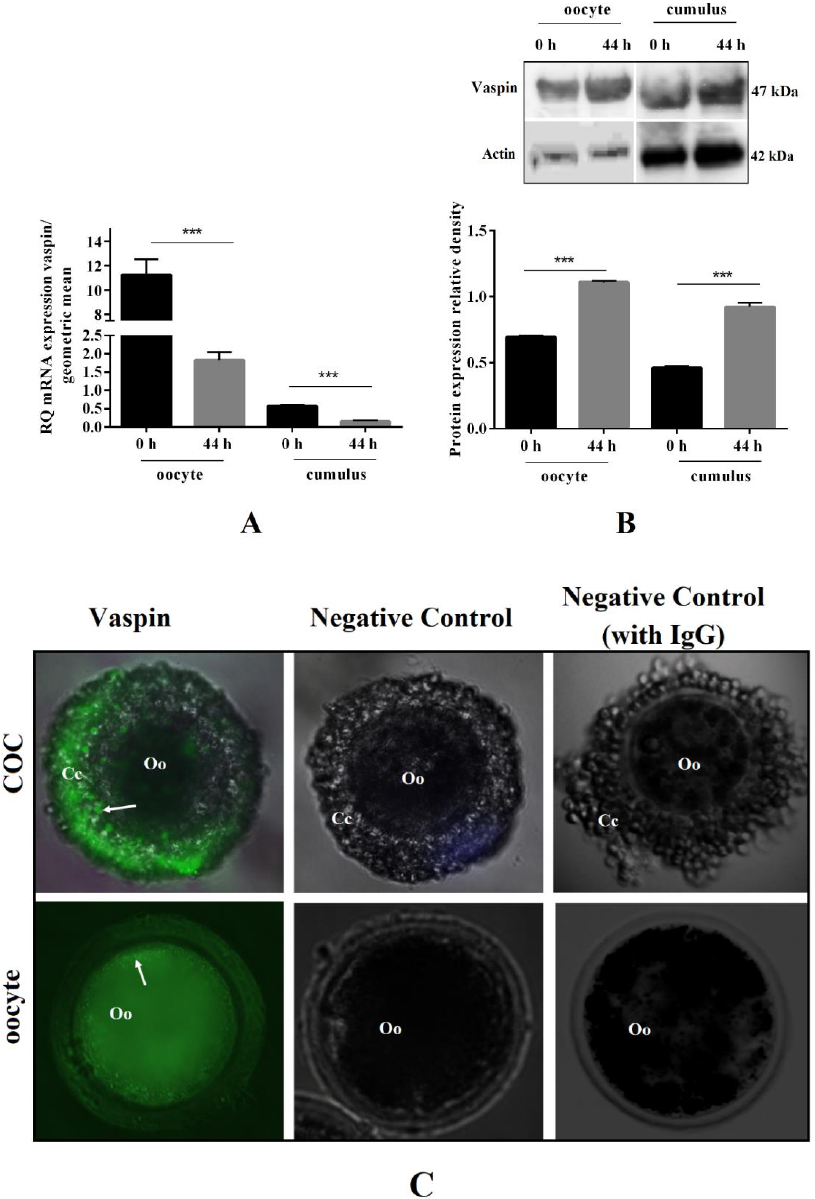
Figure 1. Vaspin mRNA and protein expression before and after oocyte in vitro maturation, as well as its immunolocalisation in cumulus–oocyte complexes (COCs). COCs (50 / group / experiment) were selected after morphological examination of material collected from the ovaries taken from 100